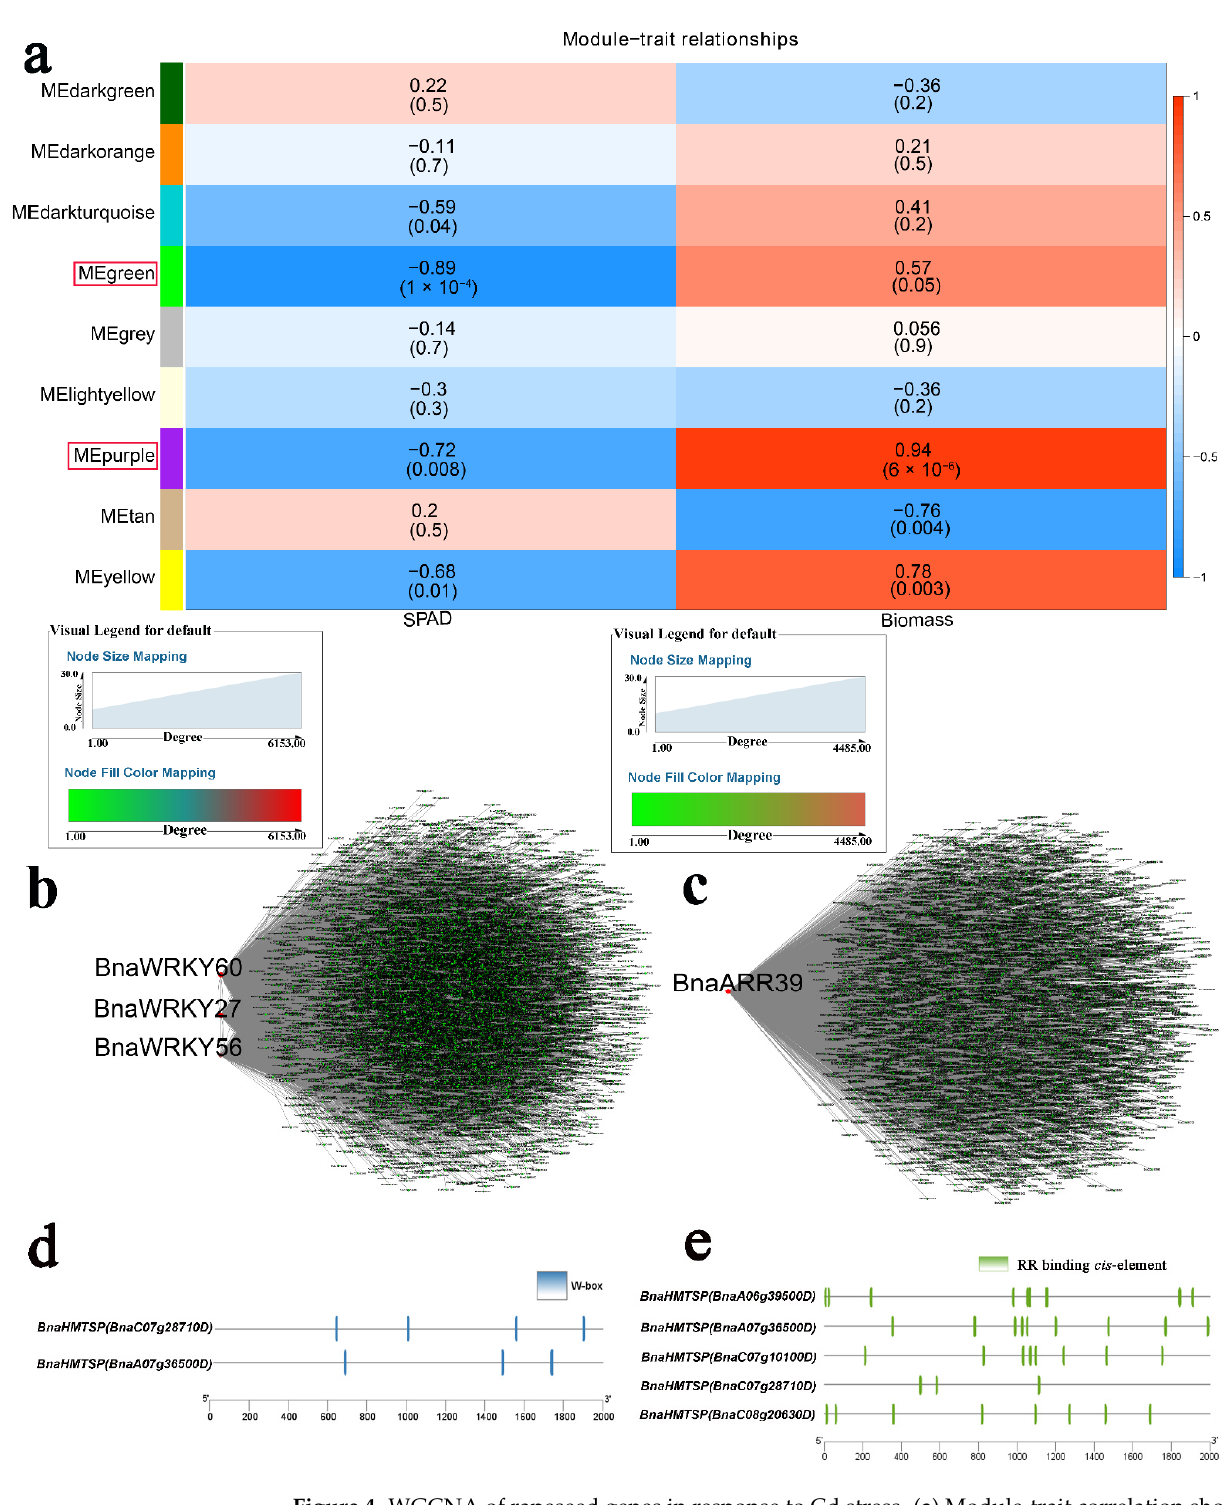
Figure 4. WGCNA of rapeseed genes in response to Cd stress. ( a ) Module-trait correlation showing the significance of module eigengene correlation with traits (SPAD and biomass). Left panel shows modules. ( b ) Cytoscape representation of the relationship of hormone-related TFs in “green” module. Key genes are represented by large red circles. ( c ) Cytoscape representation of the relationship of hormone-related TFs in “purple” module. Key genes are represented by large red circles. ( d ) W-box cis -element in promoter of BnaHMTSPs . ( e ) RR binding cis -element genes in promoter of BnaHMTSPs .